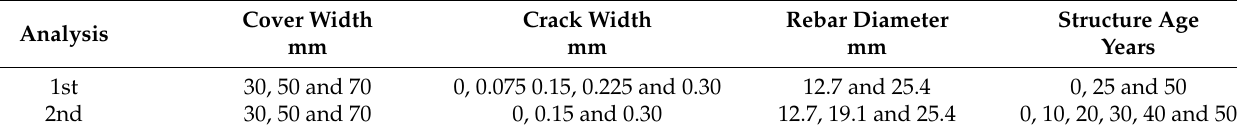
Table 1. Parameters and their ranges considered by the parametric analyses.